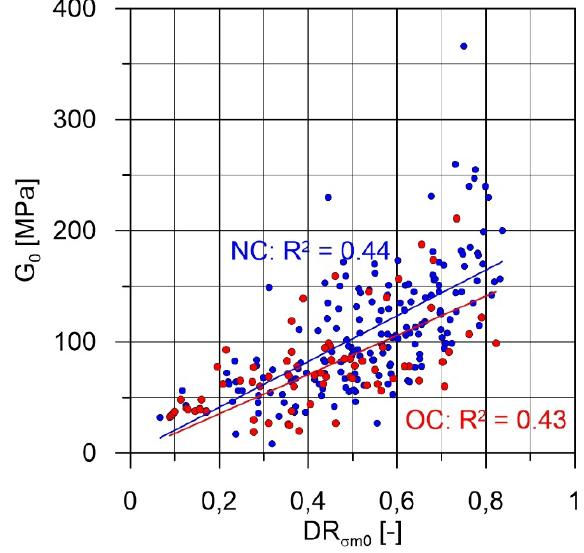
and D determined based on Eq. 0 r m0